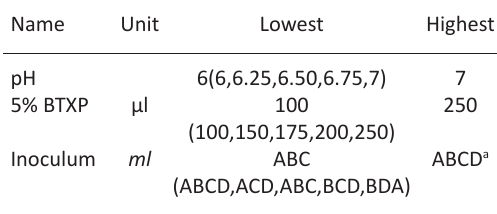
Table 2. The selected parameters and their value applied in the Response surface methodology-optimal design model for process